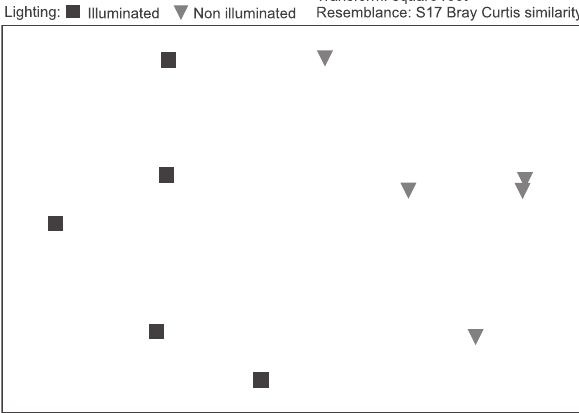
Figure 3. Multidimensional scaling (MDS) showing the existence relation to the ocean in illuminated and non-illuminated areas; formation of distinct groups (stress = 0.02) in samples collected in Merepe Beach, coast of Ipojuca,